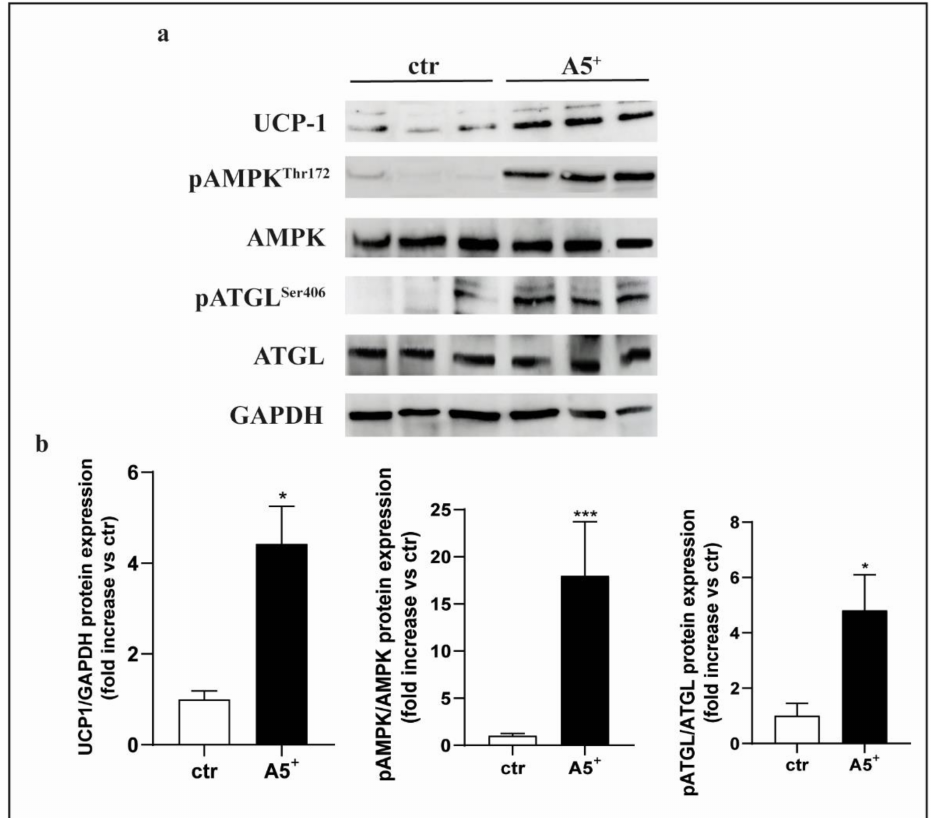
Figure 6. A5 + determined activation of AMPK-ATGL pathway in 3T3-L1 adipocytes. ( a ) Represen- tative immunoblots of UCP1, AMPK, and ATGL activation analysis ( n = 6), ( b ) distribution graphs of the densitometric scanning analyses performed by ImageQuant TL software by using GAPDH as loading control. Phosphorylated forms were normalized in comparison with their total forms. * p < 0.05; *** p <